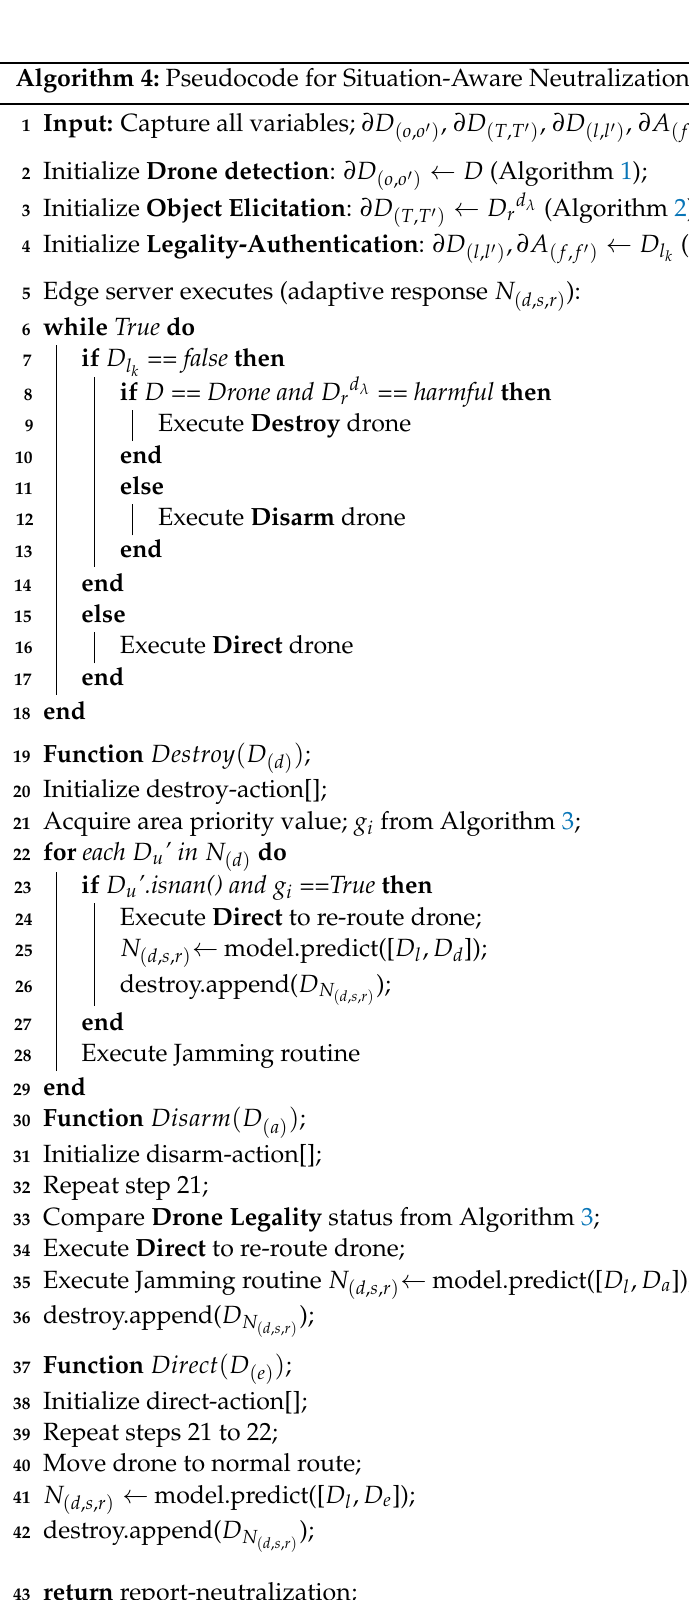
Algorithm 4: Pseudocode for Situation-Aware Neutralization ( N (